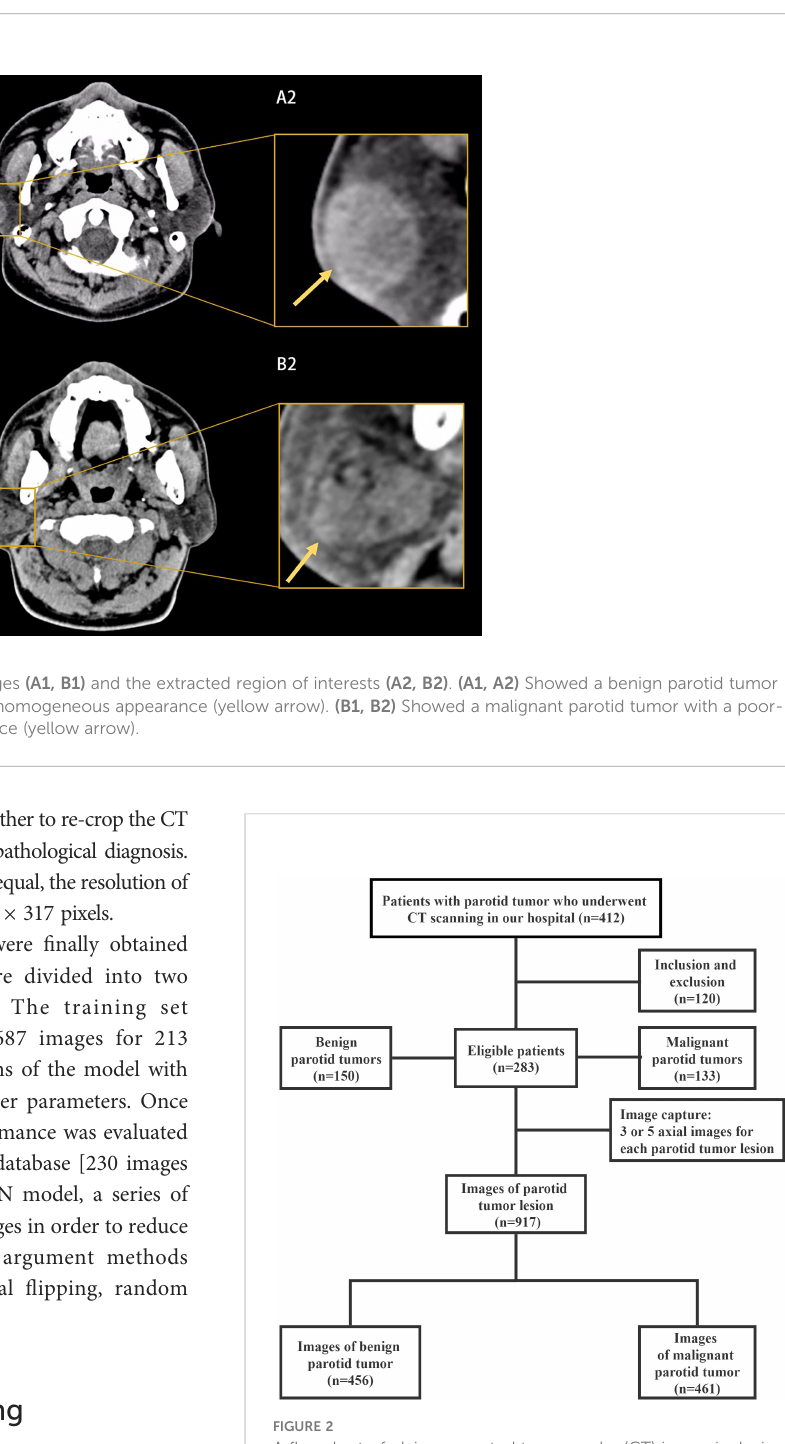
FIGURE 2 A fl owchart of plain computed tomography (CT) image inclusion and